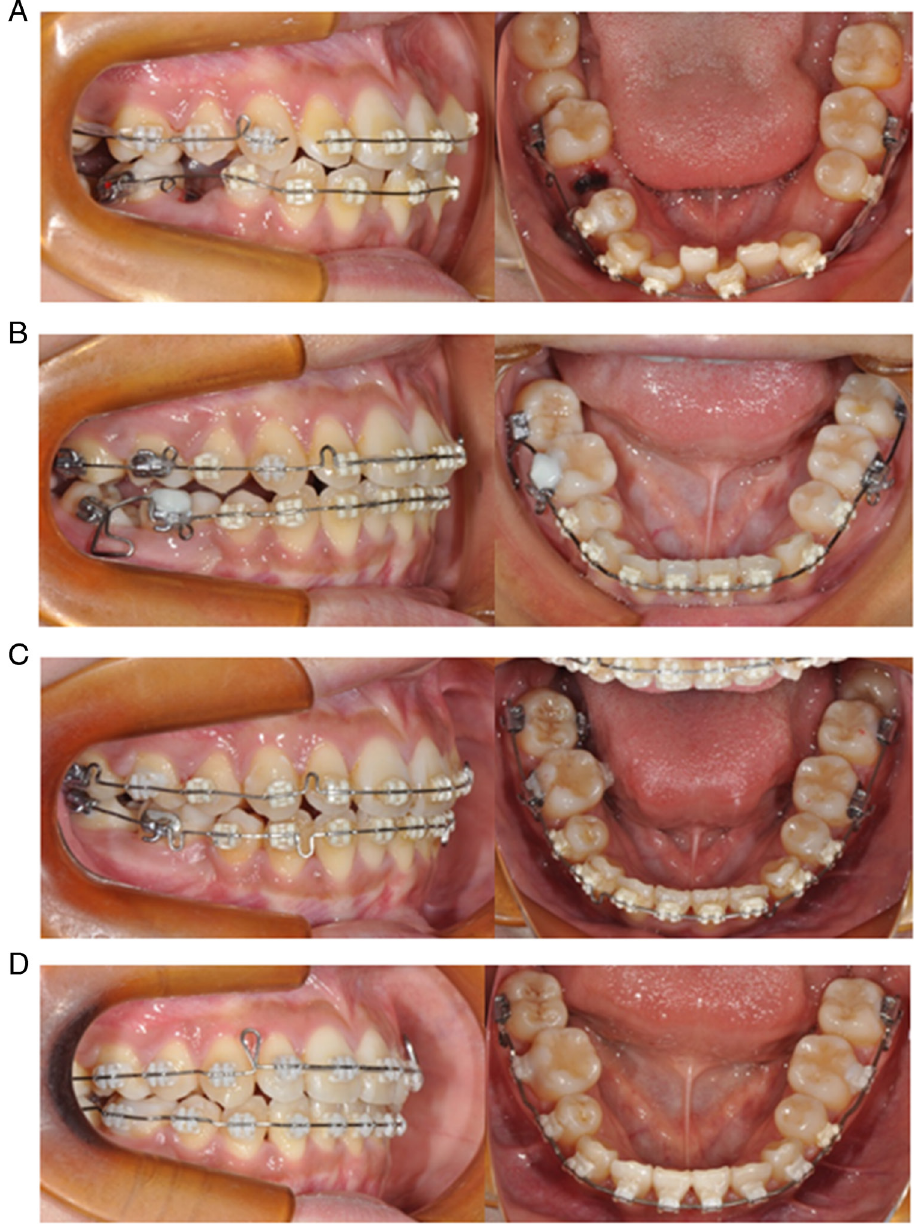
Figure 3. Progress photographs: (A) mesial movement of the mandibular right first molar, (B) mesial marginal ridge of the mandibular right second molar is confirmed, (C) initial stage of molar occlusion using the occlusal surface of the mandibular right second molar, (D) inclination of the second molar is